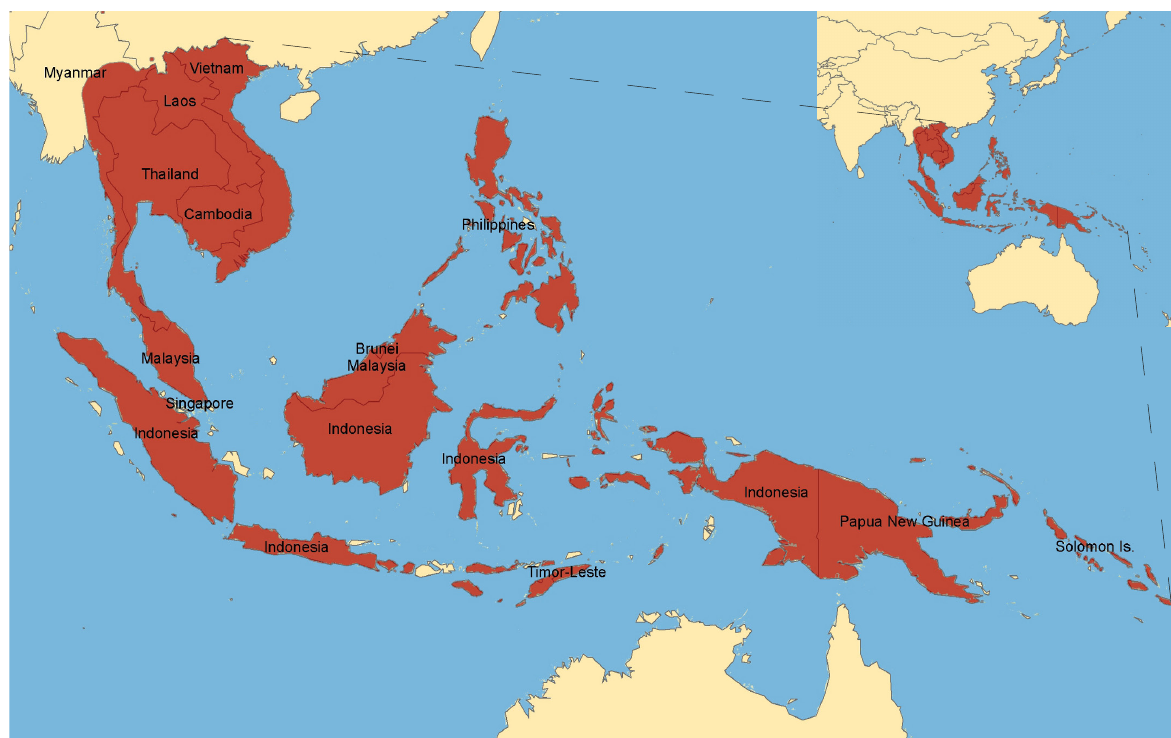
Figure 1. Geographic distribution of Rousettus amplexicaudatus . Highlights distribution in Southeast Asia and the South Pacific. Adapted from: IUCN (International Union for Conservation of Nature) 2008. Rousettus amplexicaudatus . In: IUCN 2012. IUCN Red List of Threatened Species. Version 2012.2. Figure courtesy of Bat Conservation